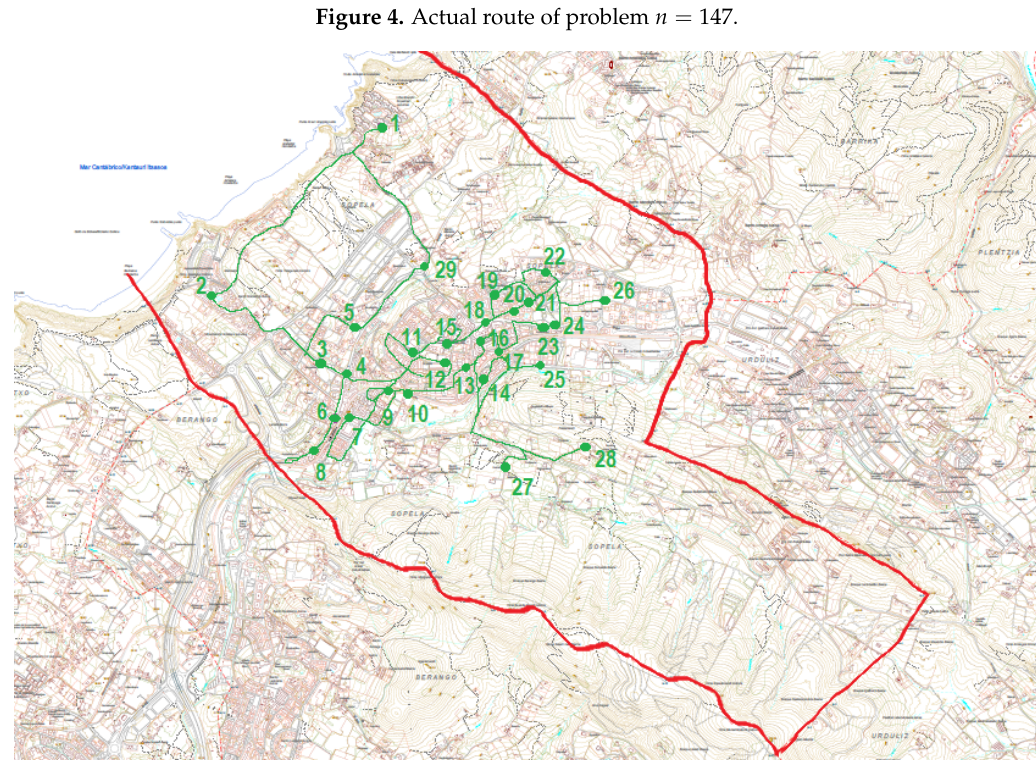
Figure 5. Smallest route obtained for problem n =